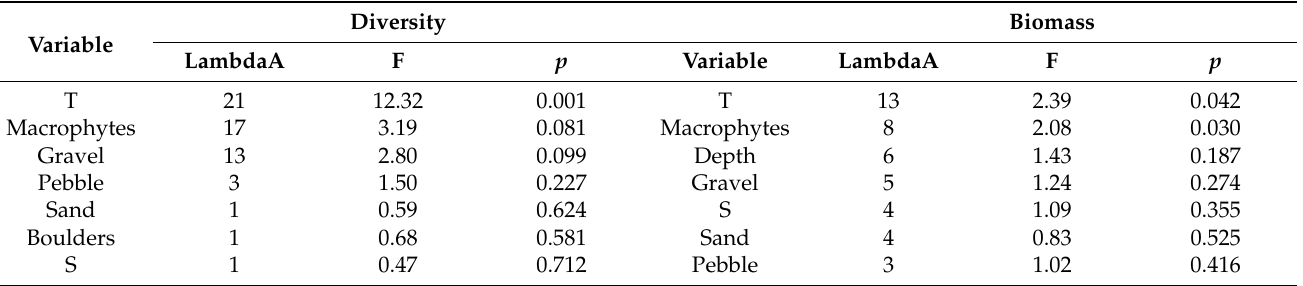
Table 3. List of environmental variables contributed to the RDA models based on the bryozoan diversity and biomass data in